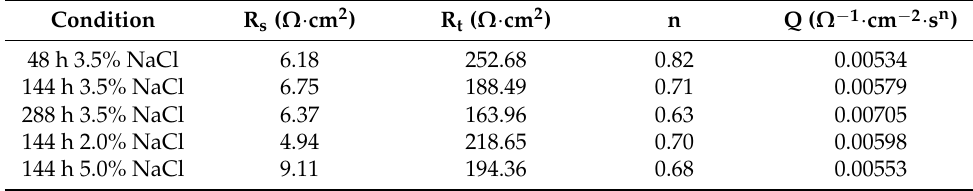
Table 2. Electrochemical impedance spectroscopy fitting parameters.